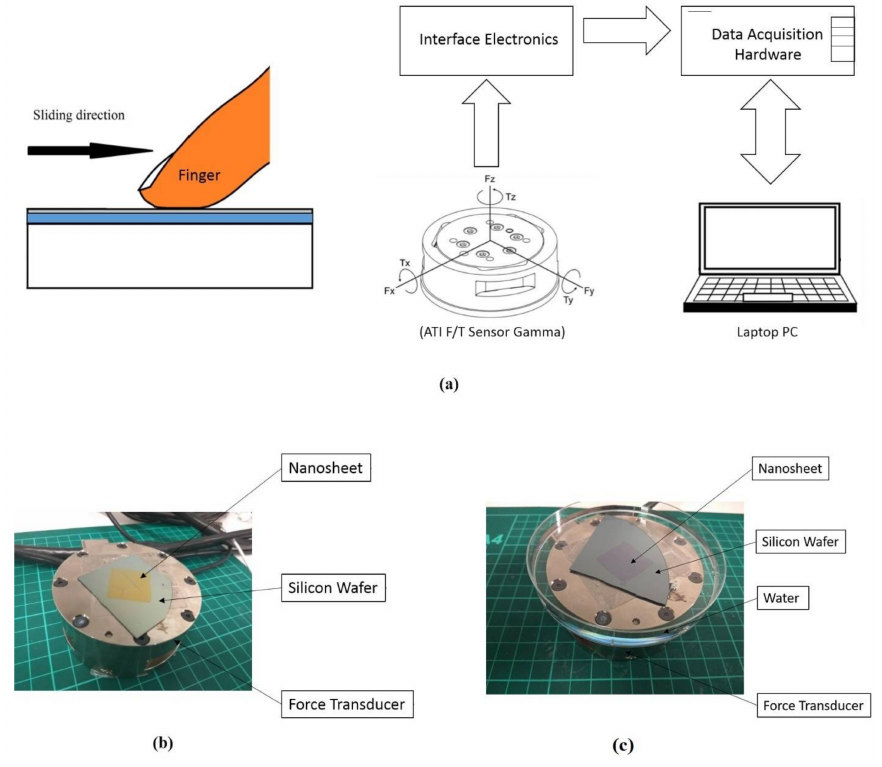
Figure 2. ( a ) Schematic figure of force transducer setup; ( b ) friction measurement in vivo under the dry condition; ( c ) friction measurement in vivo under the wet